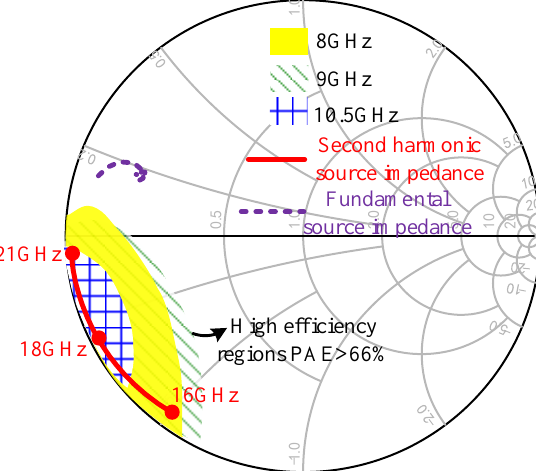
Figure 10. High-efficiency second-harmonic source impedance regions in the operation band, and the response of the second harmonic source impedance of the FET.